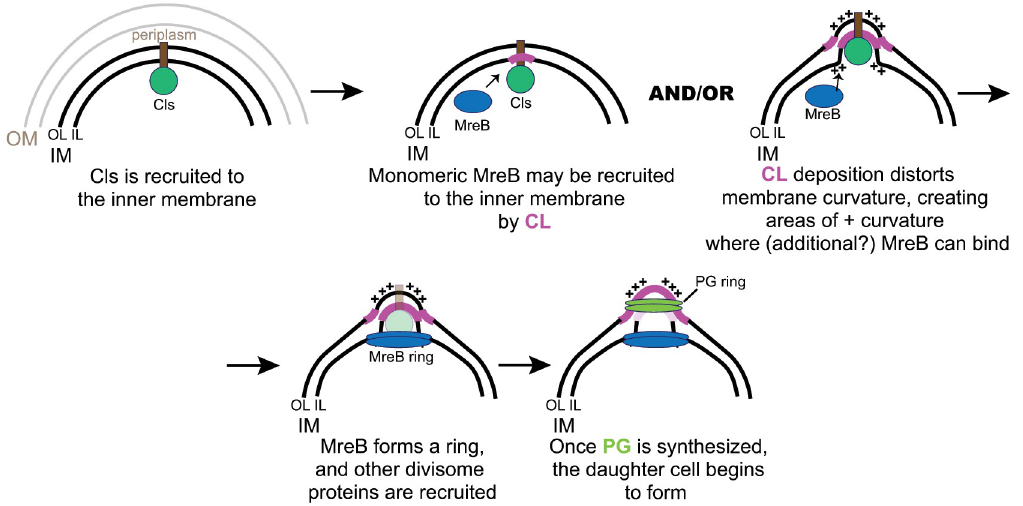
Fig 8. Model for the function of cardiolipin (CL) and Cls in chlamydial cell division. How Cls is recruited to the membrane at a distinct site is not understood but requires the transmembrane domain. An initial deposition of CL may either directly recruit MreB or induce membrane curvature that recruits MreB, and these are not mutually exclusive. Once MreB forms a ring, it recruits subsequent cell division machinery to allow peptidoglycan (PG) synthesis in the periplasm. OM = outer membrane; IM = inner membrane; OL = outer leaflet of IM; IL = inner leaflet of IM; ++ = areas of positive membrane curvature in each leaflet of the